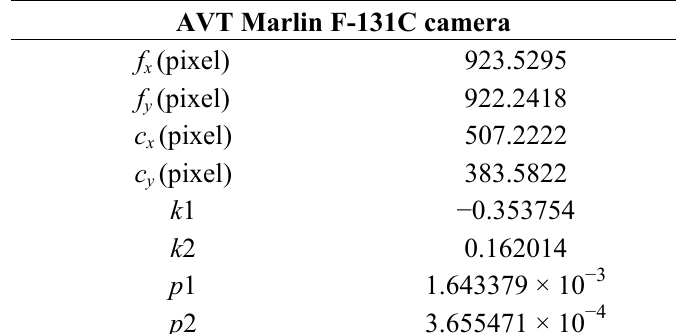
Table 3. Intrinsic camera parameters of the camera in use (Reproduced with permission from